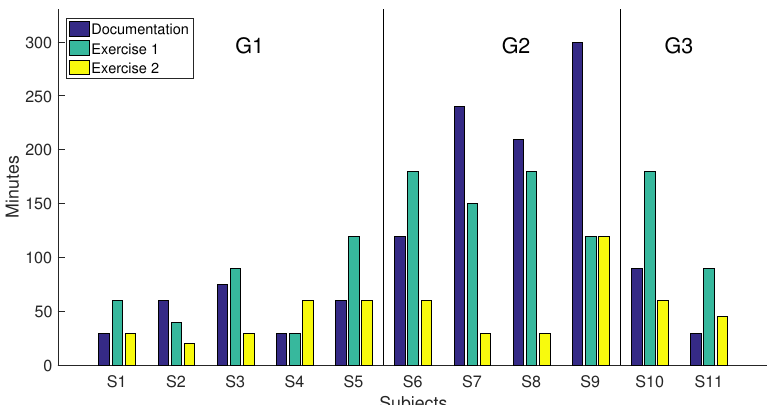
Figure 8. Time spent by participants to carry out the suggested activities.